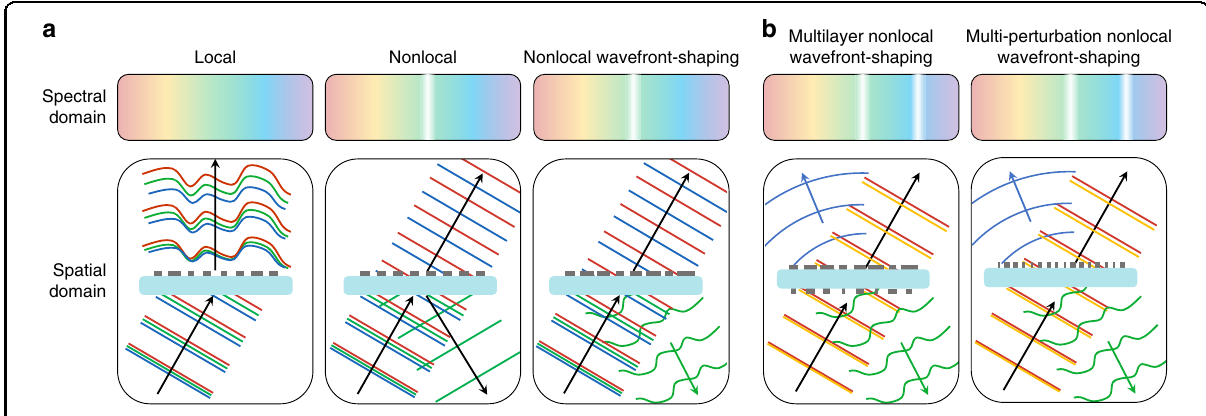
Fig. 1 Functionality of resonant, wavefront-shaping metasurfaces. a Schematic illustrating the distinction between three types of metasurfaces. The nonlocal wavefront-shaping metasurface demonstrated in this work provides spatial control exclusively across its sharp spectral features: it molds optical wavefronts only at the resonant frequency, while leaving the optical wavefronts impinging at other frequencies unchanged. b Schematic illustrating two approaches to realize multifunctional nonlocal wavefront-shaping